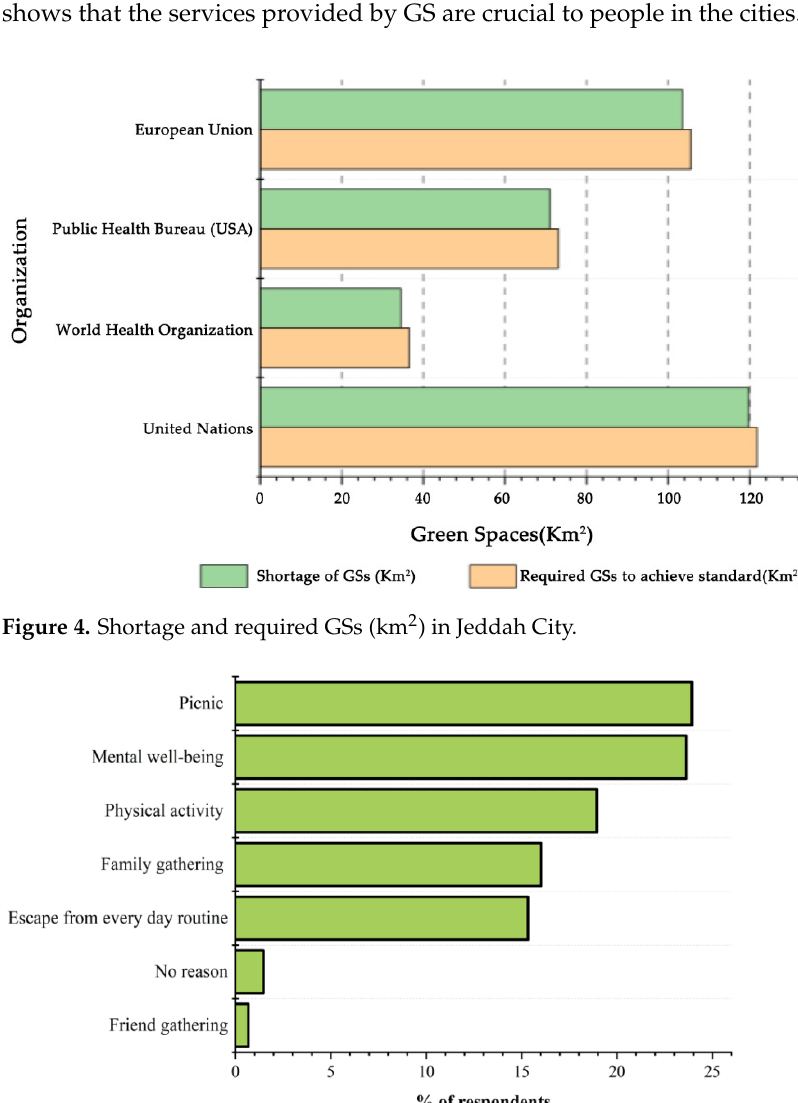
Figure 3. Spatial distributions of GSs in Jeddah City ( a ); Jeddah satellite image with the GSs; ( b ) GSs distribution in Jed- dah in regard to the city urban growth boundary and; ( c ) detailed view to the GSs in the city.